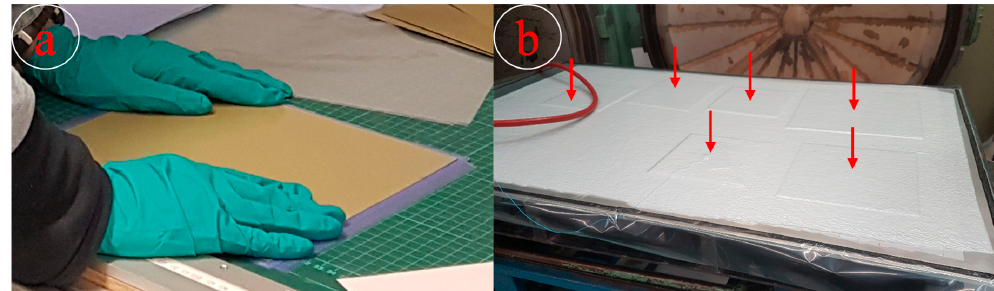
Figure 11. ( a ) Hand lay-up of the GLARE stack; ( b ) breather fabric and air-tight plastic foil covering the GLARE panels on the stainless-steel bed of the autoclave prior to curing; red arrows indicate the location of GLARE panels on the autoclave bed.